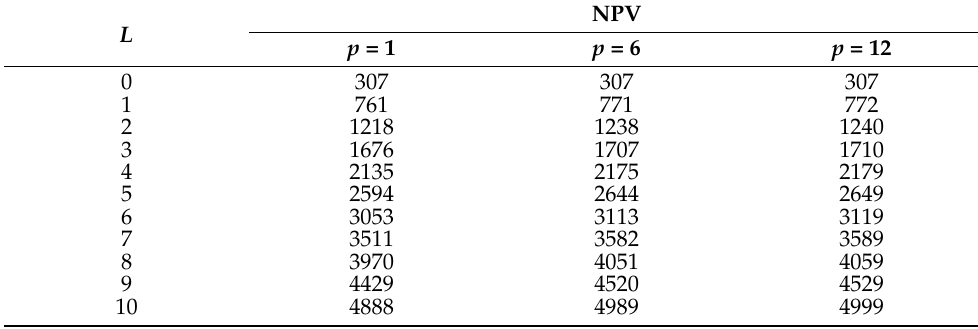
Table 6. Dependence of NPV on leverage level L at k 0 = 0.22, k d = 0.14 and different p = 1, 6, 12 for a three-year